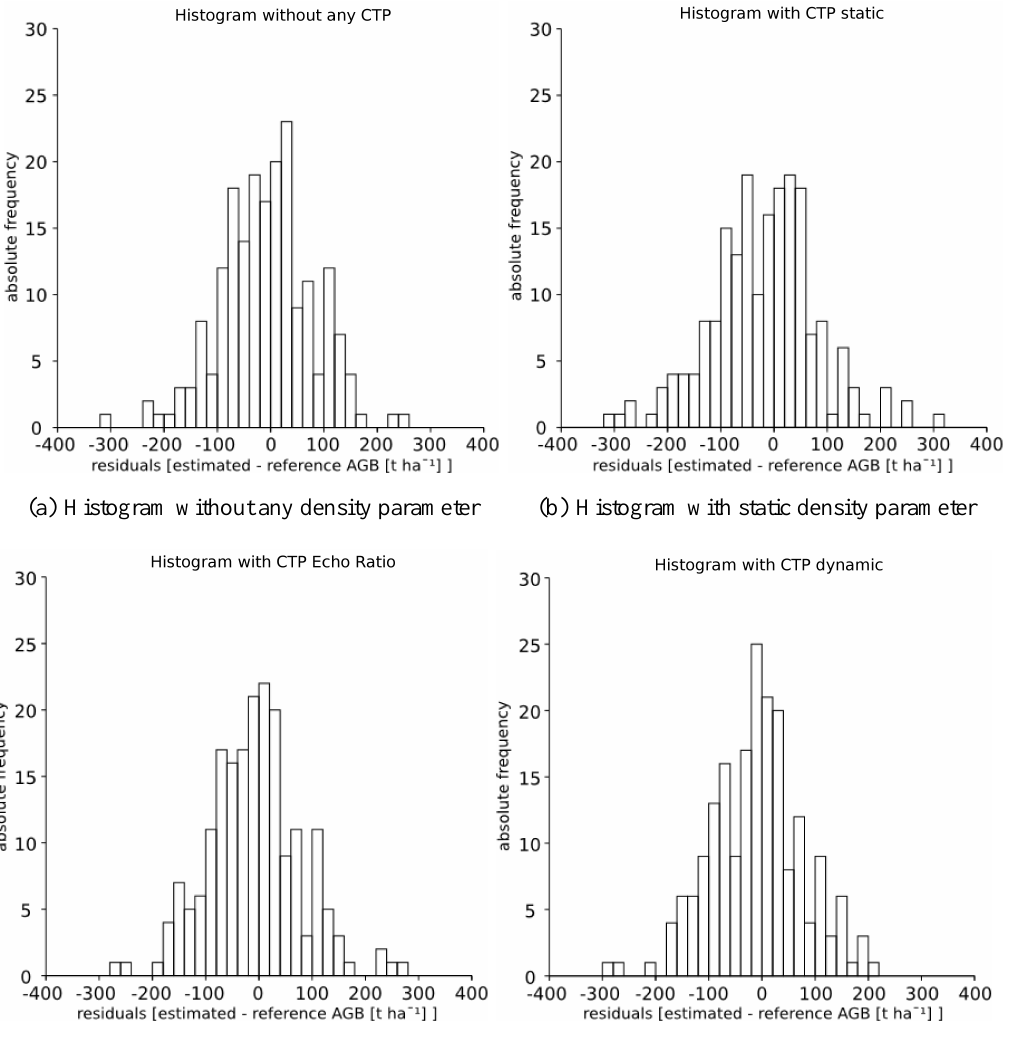
Figure 5. The histograms show the frequency distribution of residuals (estimated minus reference AGB) of all 196 sample plots for all investigated